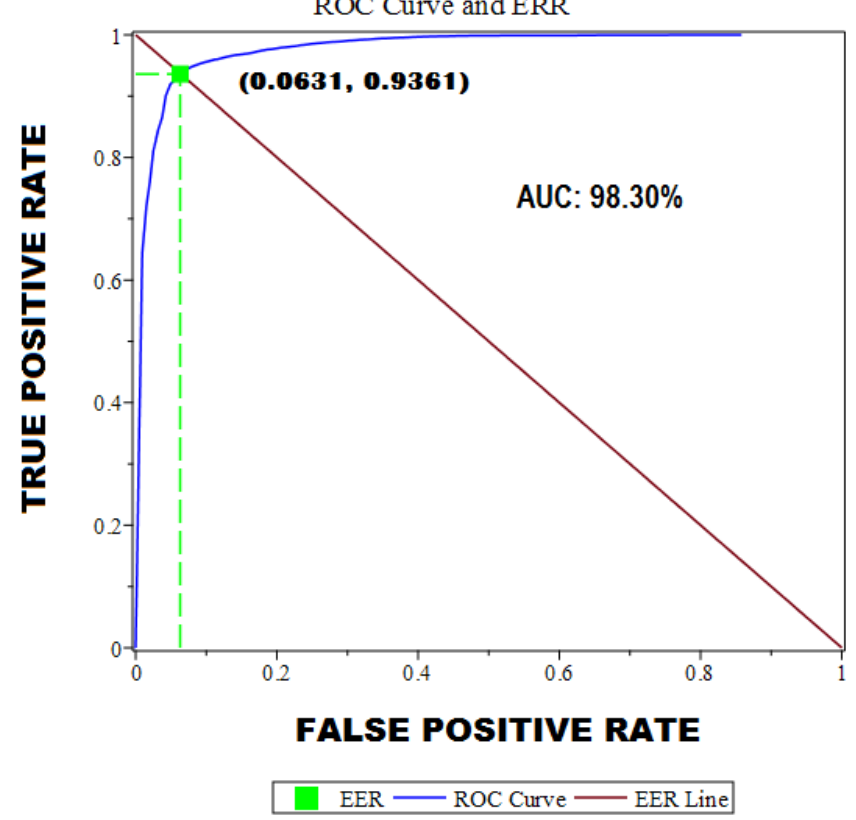
Figure 5. ROC curve, EER point, and area under the ROC curve (AUC) of the experiments carried